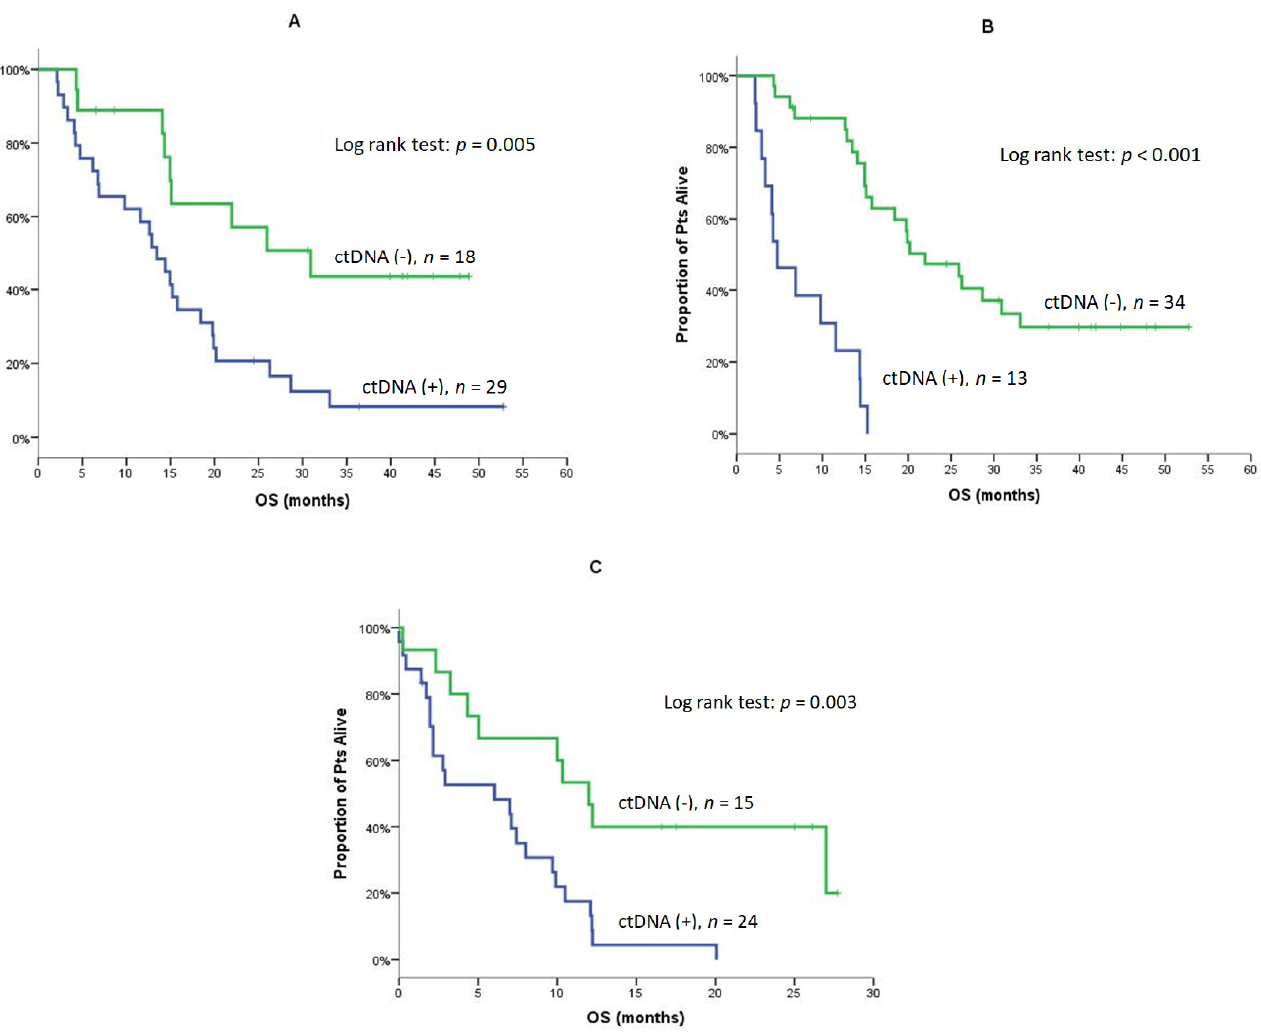
Figure 1. PFS for patients with detectable and non-detectable ctDNA at baseline.